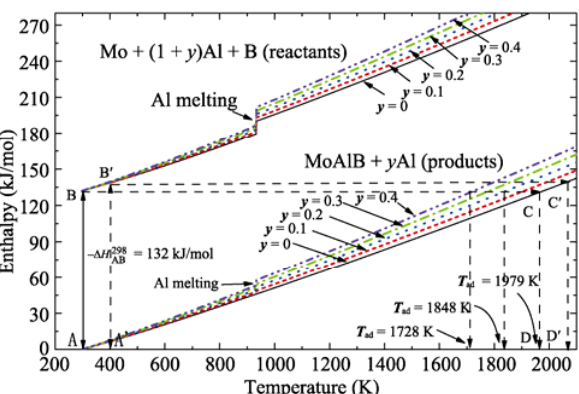
c and T ad H / 298K Fig. 9 Relationship between −Δ 298K p r for the selected compounds. Most compounds are reported in Ref. [47]. Compounds marked in ■ and □ are MAB phases and binary borides, respectively, and compounds marked in ● and ○ are MAX phases and binary carbides, respectively. Self-sustaining regime on the right indicates that the material can be synthesized by c ≥ H / 298K SHS method with T ad ≥ 1800 K and −Δ 298K p r 2000